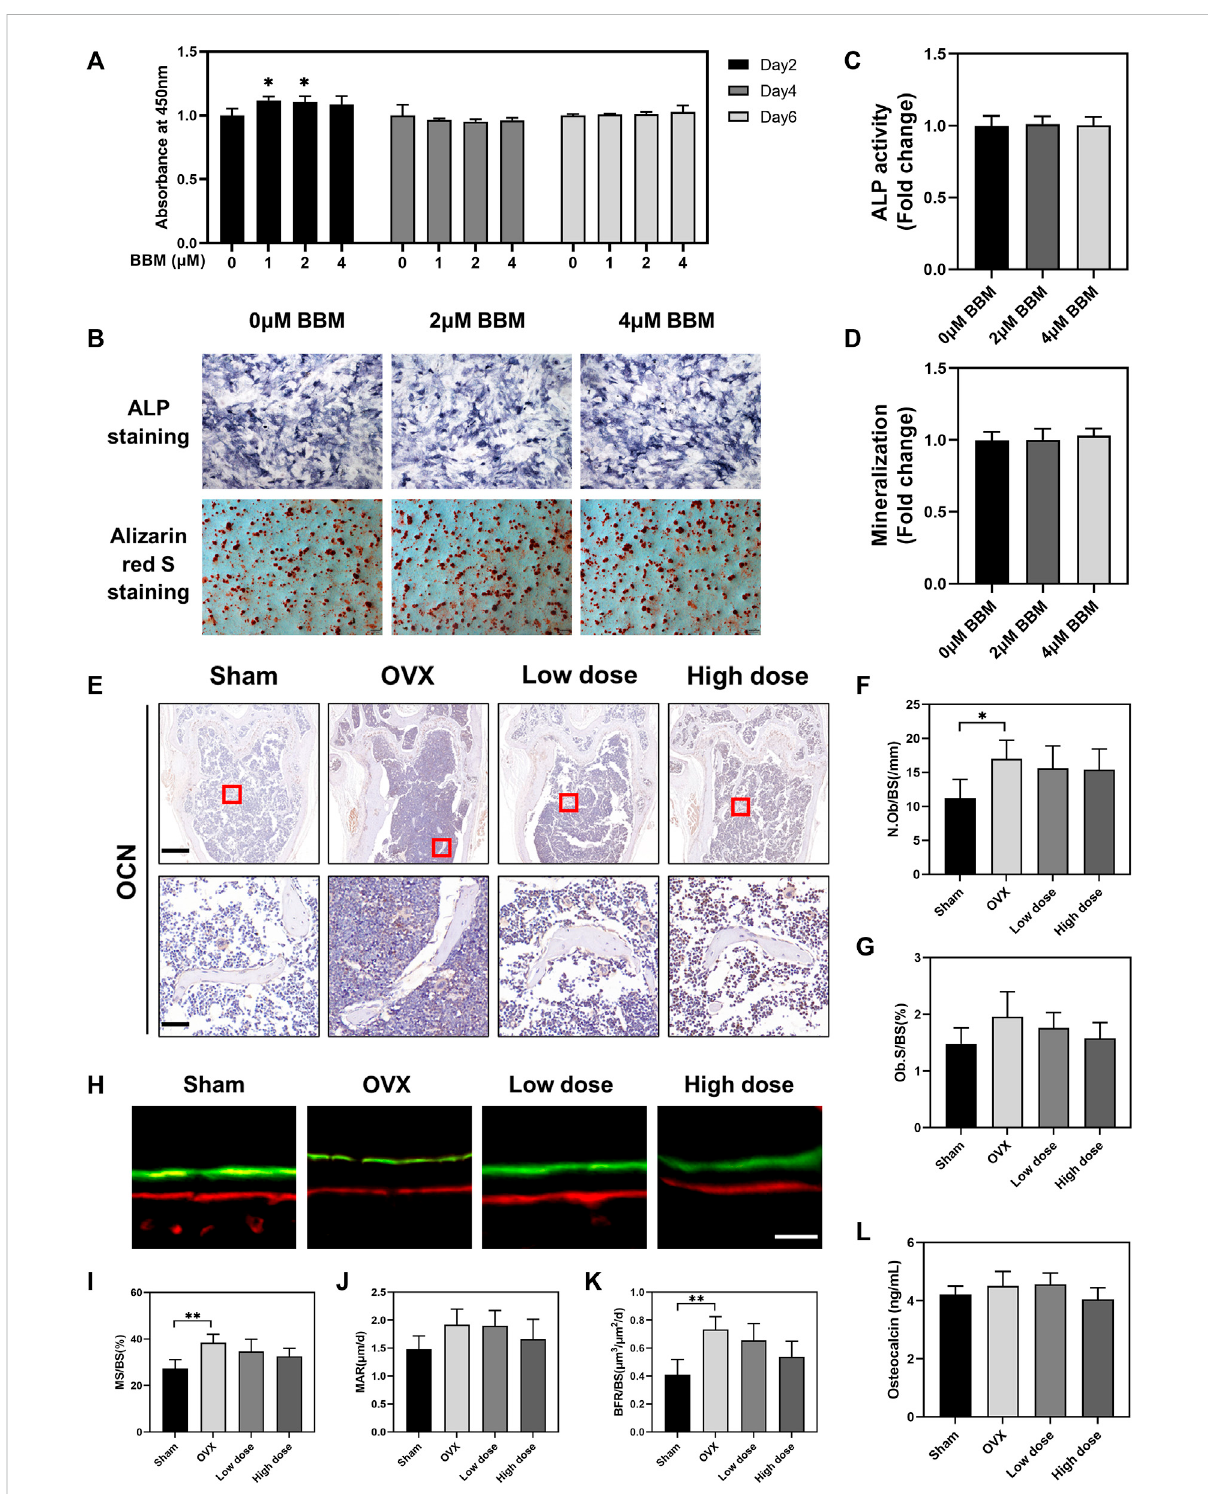
FIGURE 7 BBM does not in fl uence osteogenic differentiation in vitro or in vivo . (A) MC3T3-E1 cells were treated with BBM (0, 1, 2 and 4 μ M) for 2, 4 and 6 days. Cell viability was determined by CCK-8 assay. (B) Representative images of ALP and ARS staining in MC3T3-E1 cells (scale bar = 500 μ m). (C) Quantitative analysis of ALP activity in the ALP staining images. (D) Quantitative analysis of mineralization in the ARS staining images. (E) RepresentativeimagesofdistalfemursectionsimmunohistochemicallystainedforOCN(scalebar=500 μ m;scalebar=50 μ mintheenlarged pictures). (F,G) Quantitative analysis of N. Ob/BS (F) and Ob. S/BS (G) in the OCN staining images of distal femurs. (H) Representative fl uorescence images of calcein – Alizarin red S labeling (scale bar = 20 μ m). (I – K) Quantitative analysis of MS/BS (I) , MAR (J) and BFR/BS (K) in the double-labeling images. (L) Serum levels of the OCN bone formation marker quanti fi ed by ELISA. * p < 0.05 and ** p < 0.01 compared to the control